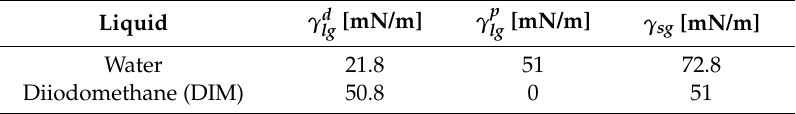
Table 2. Dispersive, polar and total components of the two